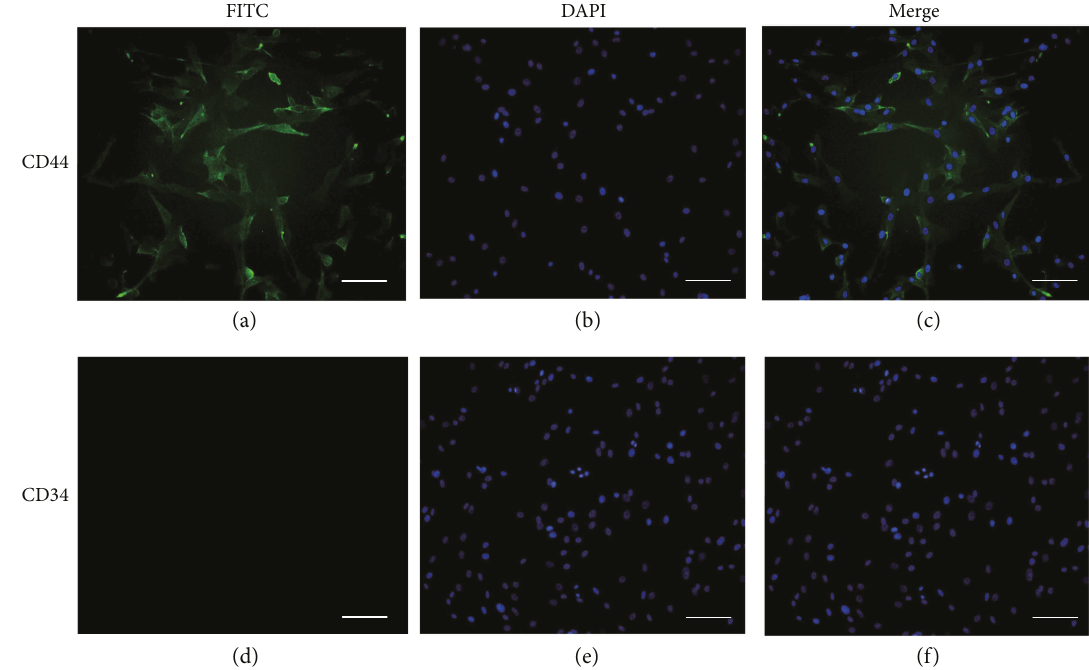
Figure 1: Immuno fl uorescence assay of UC-MSCs (scale bars =100 μ m): (a) cells incubated with anti-CD44 antibody and FITC-labeled goat anti-mouse IgG; (b, e) counterstained by DAPI; (c) the merge image of (a) and (d), cells incubated with anti-CD34 antibody and FITC-labeled goat anti-rabbit IgG; (b, f) the merge image of (d) and